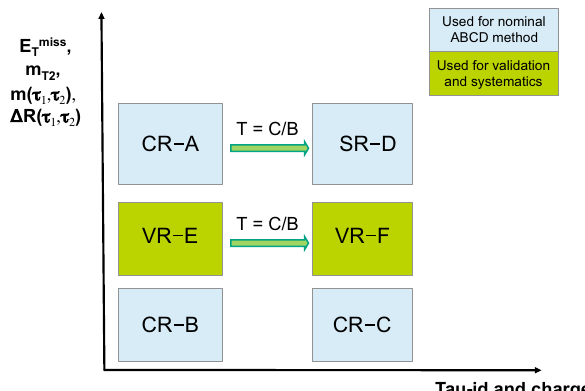
Fig. 2 Illustration of the ABCD method for the multi-jet background determination. The control regions A, B, C, and signal region D for the ABCD method described in the text (labelled as CR-A, CR-B, CR-C and SR-D) are drawn as light blue boxes. Shown in green and labelled as VR are the regions E and F, which are used to validate the ABCD method and to estimate the systematic uncertainty. The definition of all regions used in the ABCD method can be found in Table 2